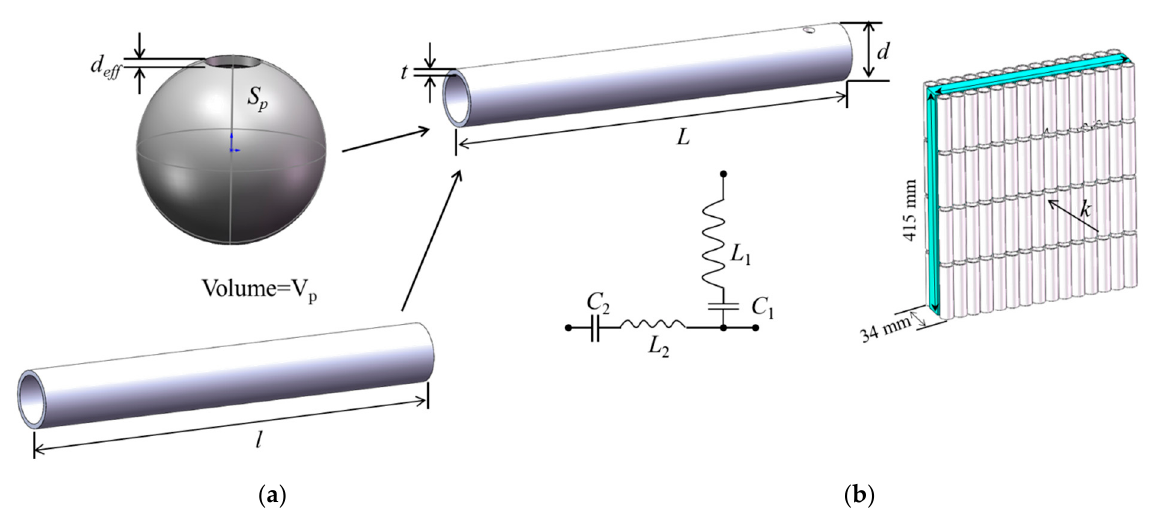
Figure 4. Flute-like metamolecule acoustic metamaterial: ( a ) The structure of metamolecule; ( b ) the schematic diagram of the sample .